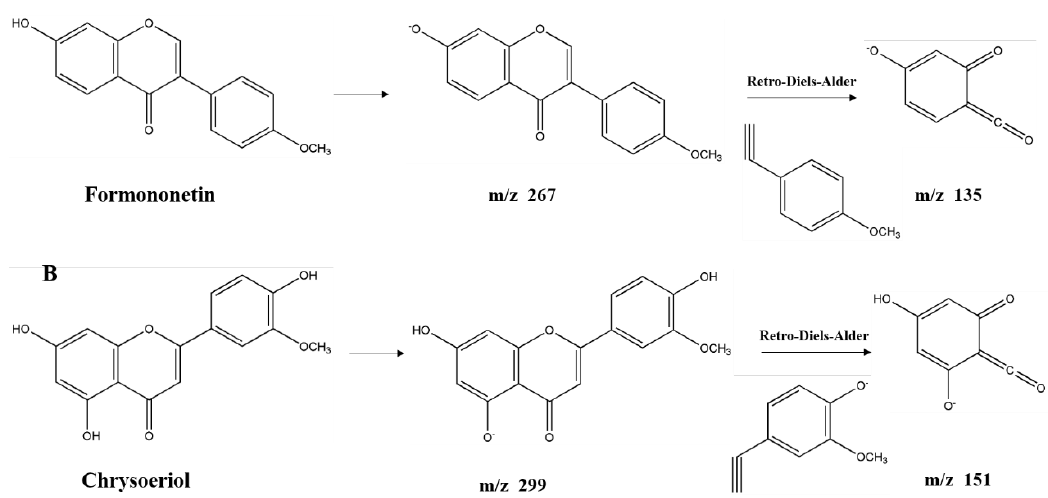
Figure 3. Structure of new compounds detected in AFH. Formononetin ( A ) and chrysoeriol ( B ). A total of 10 phenolic compounds were quantified based on extracted ion chromatograms (EIC) enabled different standards, and the contents as well as EIC are shown in Supplementary material in Table S1 and Figure S1. Syringic acid (36.43 ± 0.71 mg/kg) was the most abundant phenolic acid in